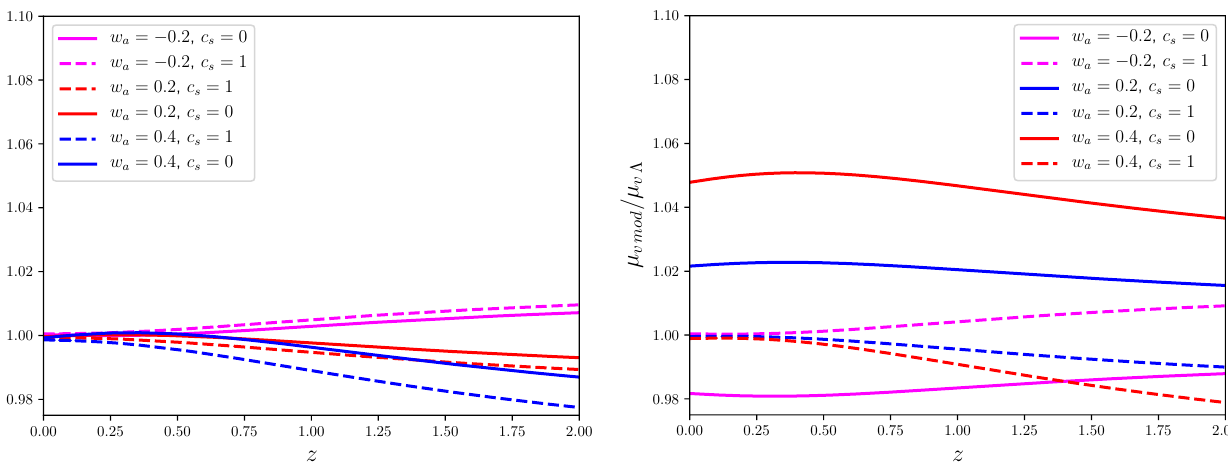
Figure 6. Evolution of µ c ( left panel ) and µ v ( right panel ) with redshift, defined in Equation (94), divided by the corresponding function in the Λ CDM model for homogenous and CDE models, with w 0 = 1 and different values w a and c s indicated in the legends. Due to the small impact of distinct − DE models on δ c , the differences in µ c with respect to the case with Λ are very small at z reach about 2% at z 2. In the case of CDE, the differences in µ v are larger and also present at low z (cid:39)